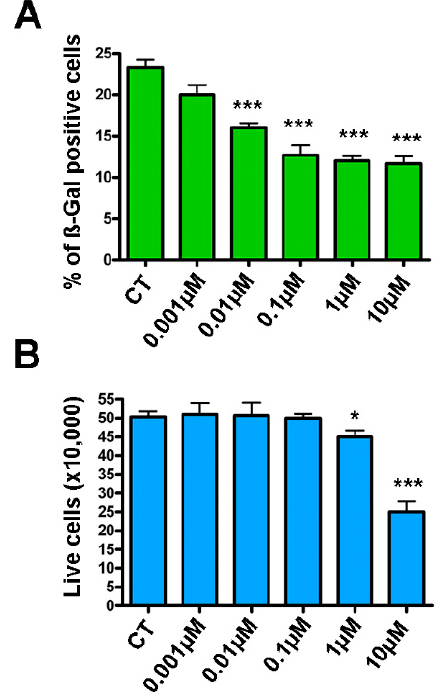
Figure 1. Effects of piceatannol on acute senescence. MSCs at 10 DIV were treated for 30 min with 300 μ M hydrogen peroxide to induce acute senescence, which was evaluated by beta ‐ gal assay 48 h later. Next, senescent cultures were incubated with different amounts of piceatannol for another 48 h. The upper chart ( A ) shows the percentage of senescent cells at the end of piceatannol treatment. The lower chart ( B ) reports the cell viability, as detected via CCK ‐ 8 assay, of cultures treated with piceatannol. Data are expressed in arbitrary units and shown with standard deviation (SD), n = 3. *** p < 0.001 and * p < 0.05 indicate statistical significance between the control and treated samples. CT = control samples.